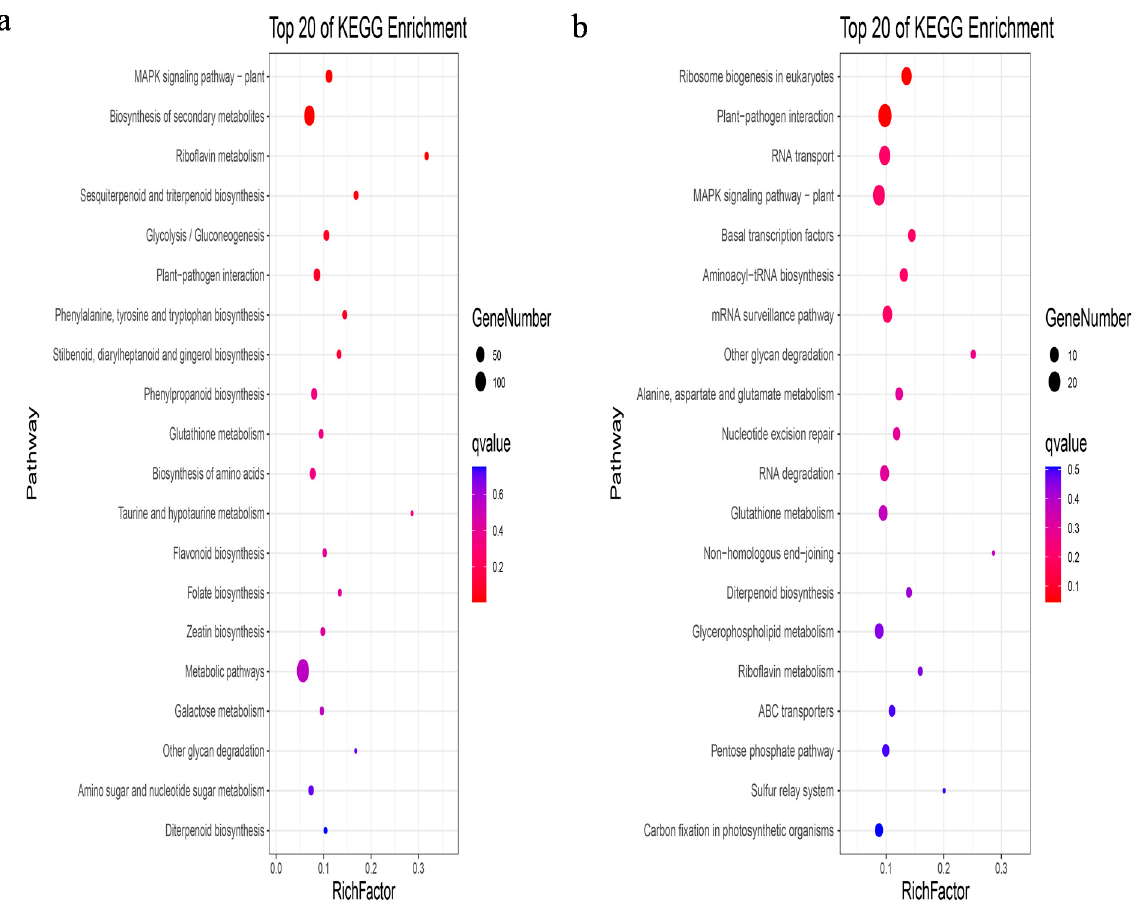
Figure 5. Path analysis of co-expressing modules of interest. ( a , b ) Top 20 KEGG-enriched pathways of indianred4 in the root and coral3 in the stem. The columns and rows represent pathways and richfactor. The richfactor refers to the ratio of the number of genes located in the KEGG pathway in the DEGs to the total number of genes located in the KEGG pathway, for all annotated genes. The round size shows the number of genes; colour bar shows the significance with qvalue. The qvalue is the false discovery rate (FDR)-corrected pvalue; redder colour indicates greater significance.